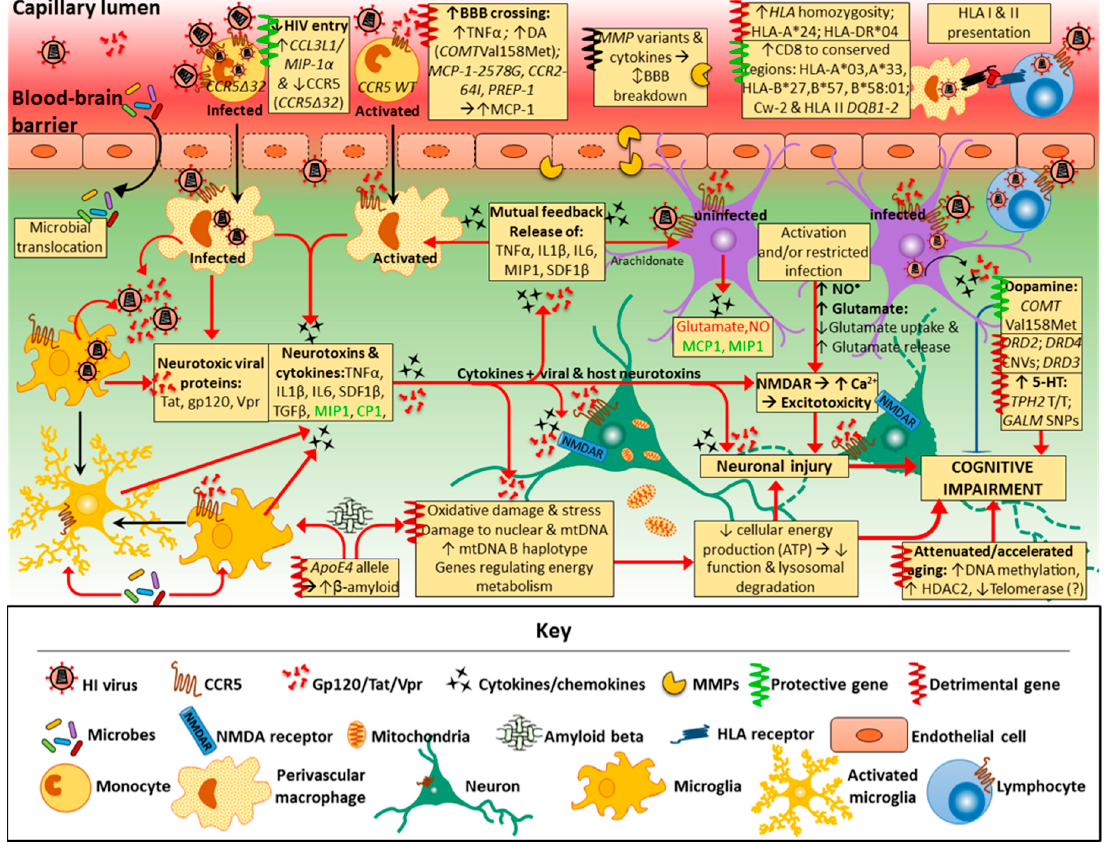
Figure 2. Pathogenic mechanisms and possible genetic influences that lead to development of HIV-associated neurocognitive disorders. HIV and its proteins (gp120, Tat, Vpr) enter the central nervous system (CNS) mainly through infected monocytes and T cells, but also via transcytosis or paracellularly. Infected and uninfected microglia, perivascular macrophages and astrocytes release neurotoxic substances (including viral proteins, if infected), inflammatory cytokines (particularly TNF- α and IL- β ), and various chemokines that further activate the same uninfected cells. Neurotoxic substances include gp120 and Tat, quinolinic acid, glutamate, arachidonic acid, and free radicals such as NO, some inflammatory cytokines (TNF- α ), and chemokines and cytokines. The resulting neuronal injury is due to functional damage, such as disruption of bioenergetic homeostasis, oxidative stress, damage to synapses and dendrites, and, to a lesser extent, apoptosis. Chemokines may be protective (some C-chemokines, such as MCP-1/CCL2, MIP-1 α /CCL3 and MIP-1 β /CCL4) or harmful (some CXC or α chemokines, such as SDF-1). Many bind to the chemokine receptor CCR5 expressed by macrophages and many astrocytes and neurons, and importantly, CCR5 also interacts as a coreceptor with gp120, perhaps directly neurotoxic. Increased glutamate is released by neurons leading to excitotoxicity; ATP and cytokines released by macrophages, and decreased glutamate reuptake by astrocytes (as macrophages release arachidonate). This increases intracellular calcium through N - methyl- D -aspartate (NMDA)-coupled ion channel receptor (NMDAR)-coupled ion channels activated by excessive glutamate and excitotoxic substances. Finally, this results in neuronal injury through free radicals, oxidative damage, and apoptotic pathways. Potential gene variants may influence pathogenic processes by altering expression of cytokines, chemokines, MMPs, HLA types. Neurotransmitter levels (affecting cognitive processes), β -amyloid deposition, susceptibility to oxidative damage and stress, as well as aging, are further affected by genotypes. Gene variants are marked by small ‘chromosomes’ on the side of text, where green indicates protective and red harmful/neurotoxic effects. ( TNF- α , tumor necrosis factor-alpha; IL-, interleukin; Tat, transactivator of transcription; gp120, glycoprotein120; NO, nitric oxide; MCP-1, monocyte chemoattractant protein; MIP-1, macrophage inflammatory protein-1; SDF-1, stromal-derived factor; NMDA, N-methyl- D -aspartate; MMP, matrix metalloproteinase; HLA, human leukocyte antigen. )